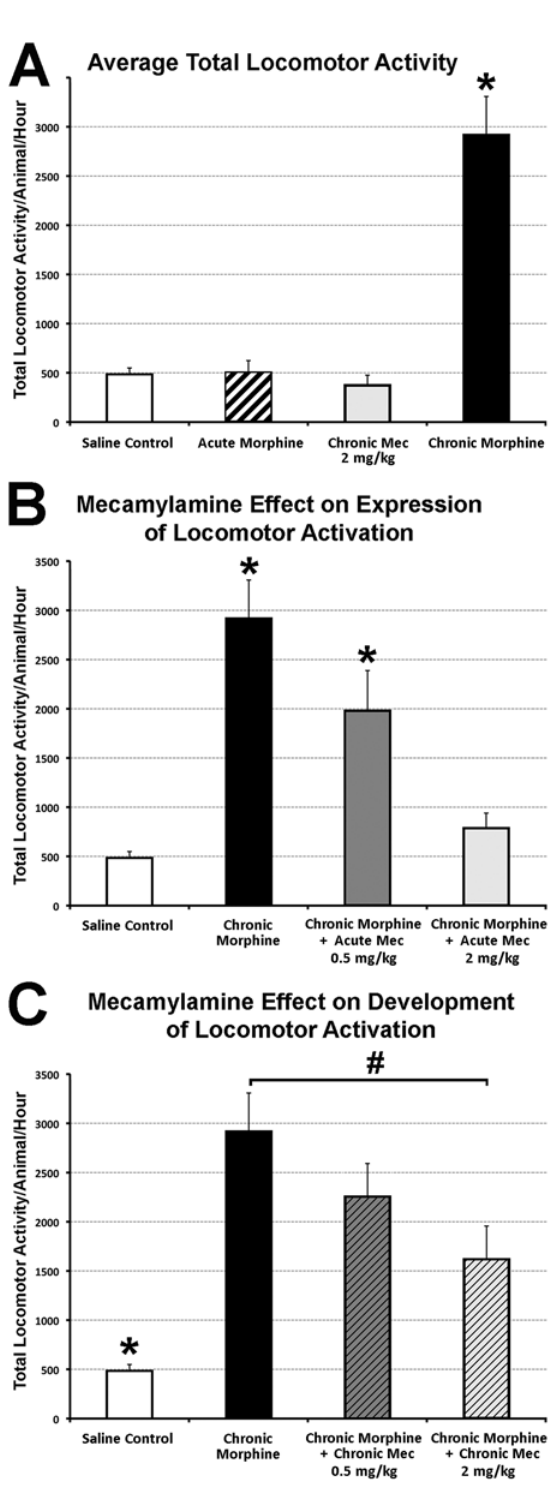
Fig 4. Behavioral Analysis of Rat Locomotor Activity. Graphs illustrate average total locomotor activity (ambulatory, fine, and rearing movements) ± SEM. (A) Chronic morphine administration (10 mg/kg sc twice-daily for 6.5 days; n = 11) was associated with locomotor sensitization when measured on day 7. It was significantly different ( F (3,30) = 26.05, p < 0.001) in comparison to saline control (n = 9; p < 0.001), acute morphine group (saline sc twice-daily for 6 days and morphine 10 mg/kg sc in the morning on day